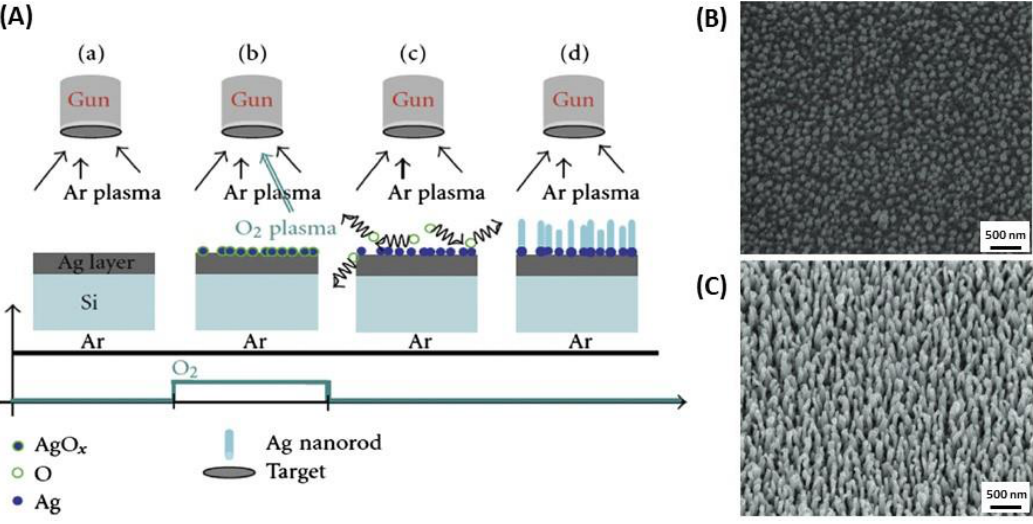
Figure 7. ( A ) Synthesis of silver nanorods by sputtering process: oxidation reduction growth (ORG). SEM images of ( B ) Ag nuclei and ( C ) AgNRs arrays. Adapted from